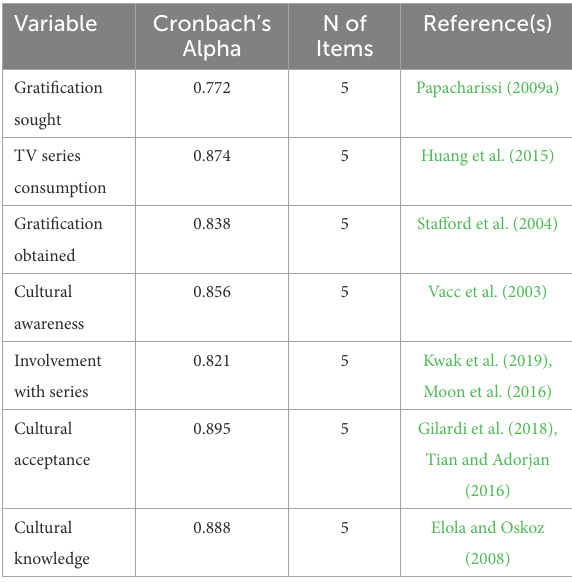
TABLE 1 Measurement and reliability